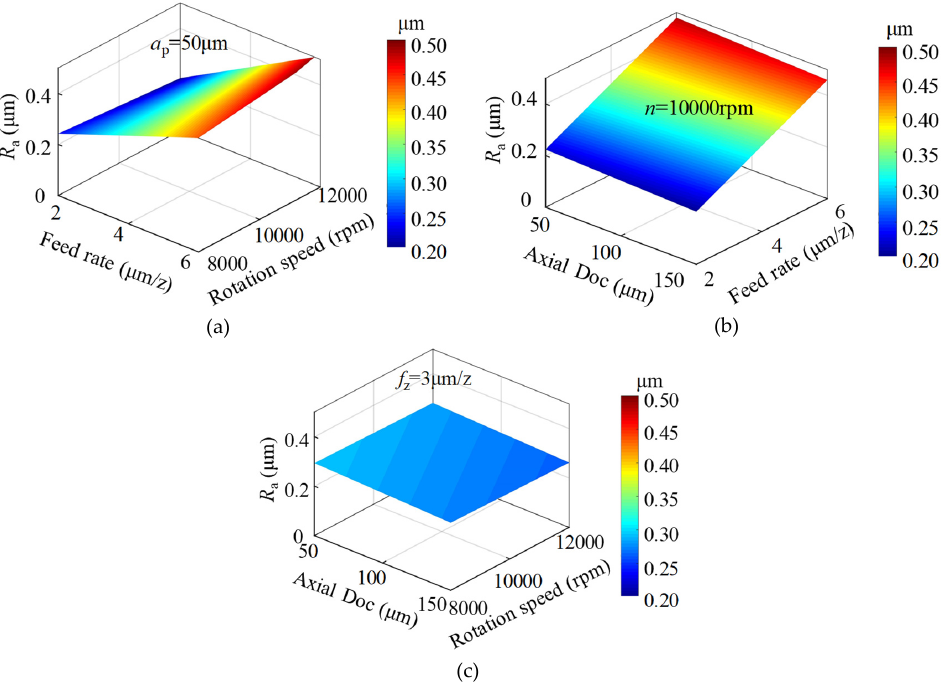
Figure 16. The parameter mutual effects on milled surface roughness of AISI304 stainless steel. ( a ) Feed rate and rotation speed; ( b ) axial DOC and feed rate; ( c ) axial DOC and rotation speed.